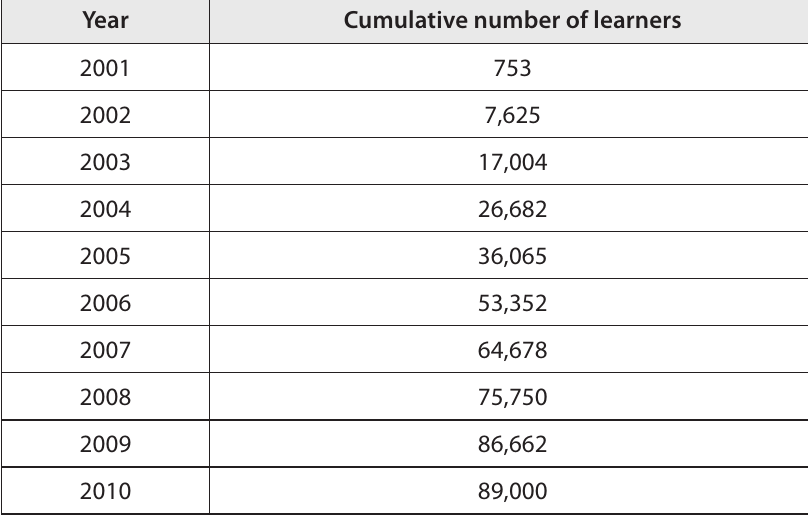
Table 4 OUM cumulative enrolment from 2001–2010 Source: OUM annual report